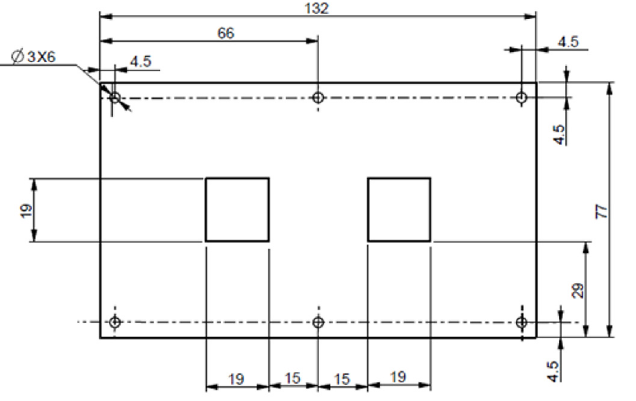
Fig. 4. Dimension details of the board.